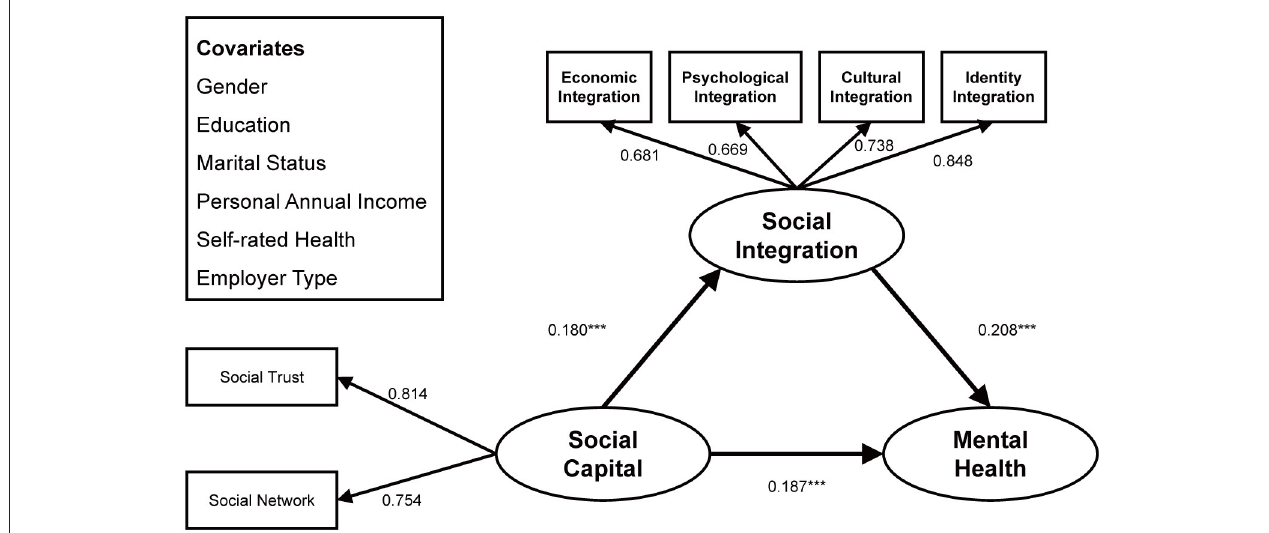
FIGURE 2 | Standardized structural model (Full sample). *** p <